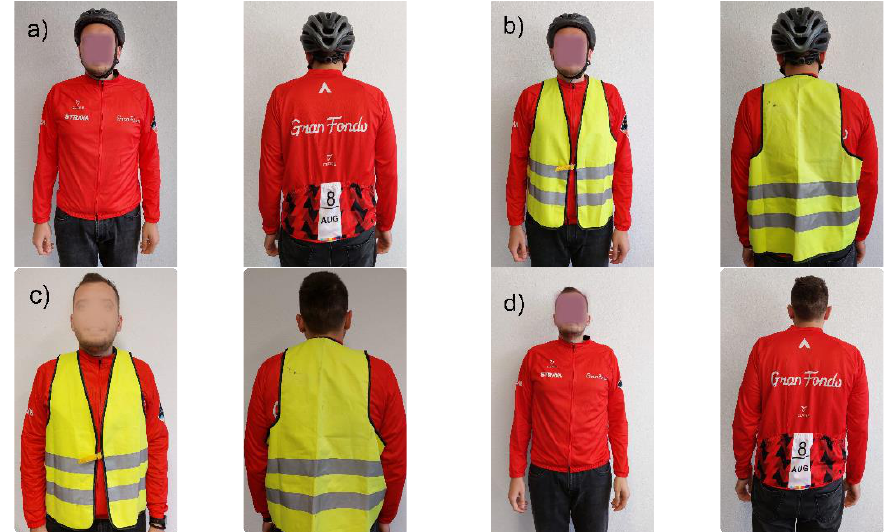
Figure 3. E-bicycle rider with a protective helmet ( a ), with a helmet and vest ( b ), with a vest ( c ), as well as without equipment (helmet and vest) ( d ).